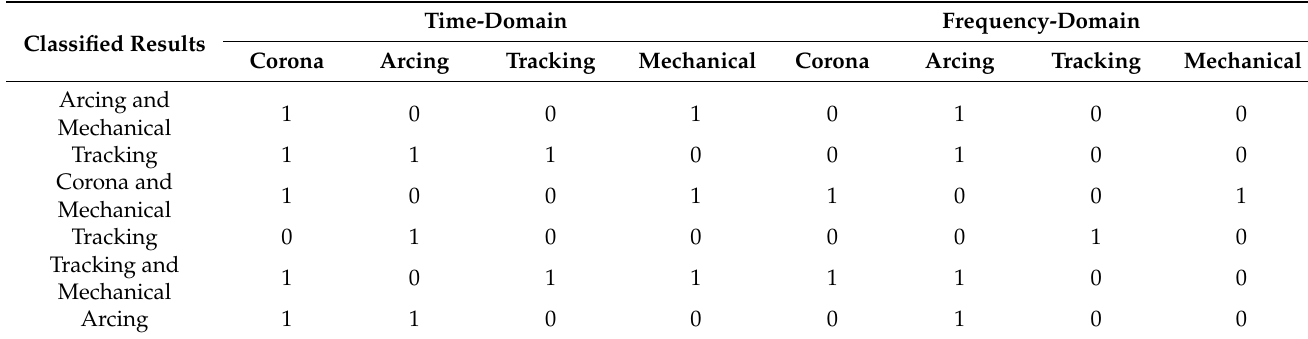
Table 17. Results based on severity.